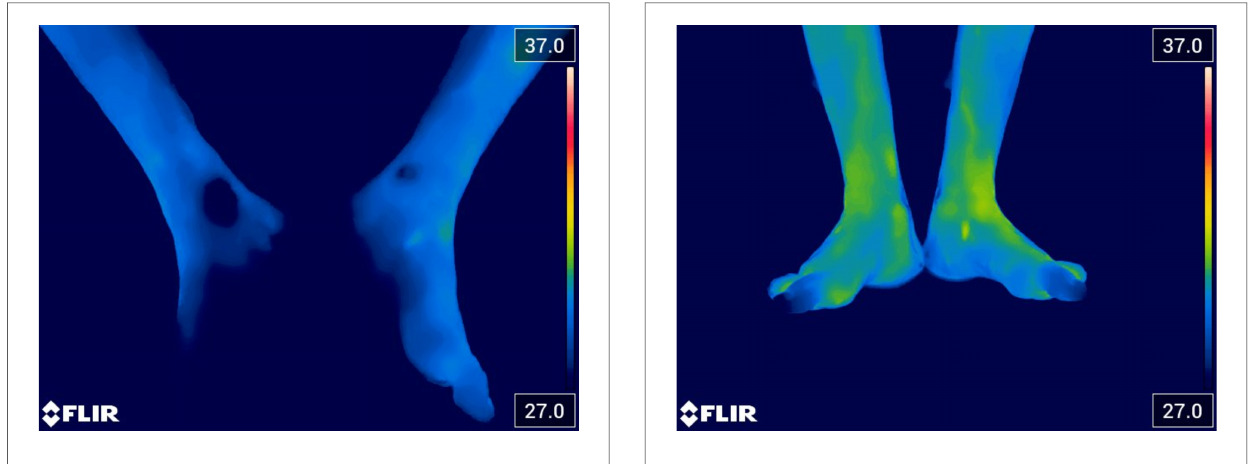
FIGURE 3 Thermal image acquired one week after administration of REAC NPO treatment. The image highlights a further improvement of the bilateral vasospasm in the two limbs.